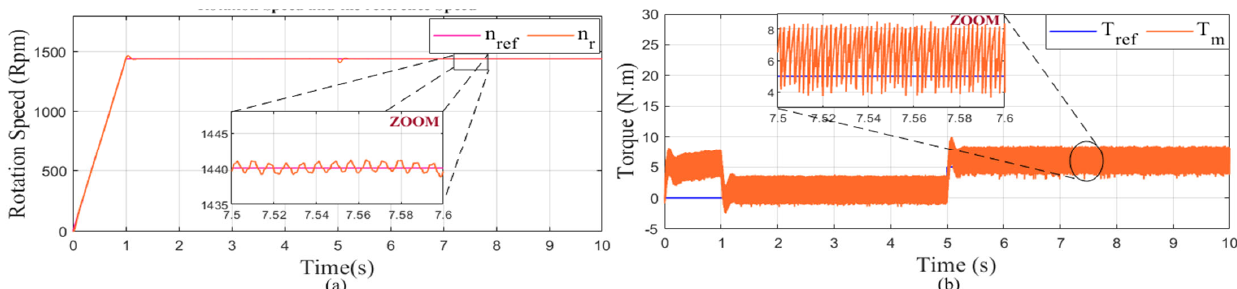
Figure 26. Performance in healthy state of IM with DTC control: ( a ) rotation speed and ( b ) motor torque.